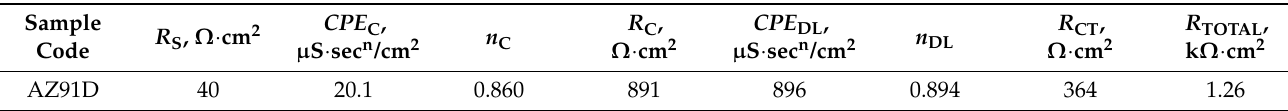
Table 8. Equivalent circuit parameters obtained from the fitting of the EIS experimental data for the uncoated AZ91D Mg alloy.